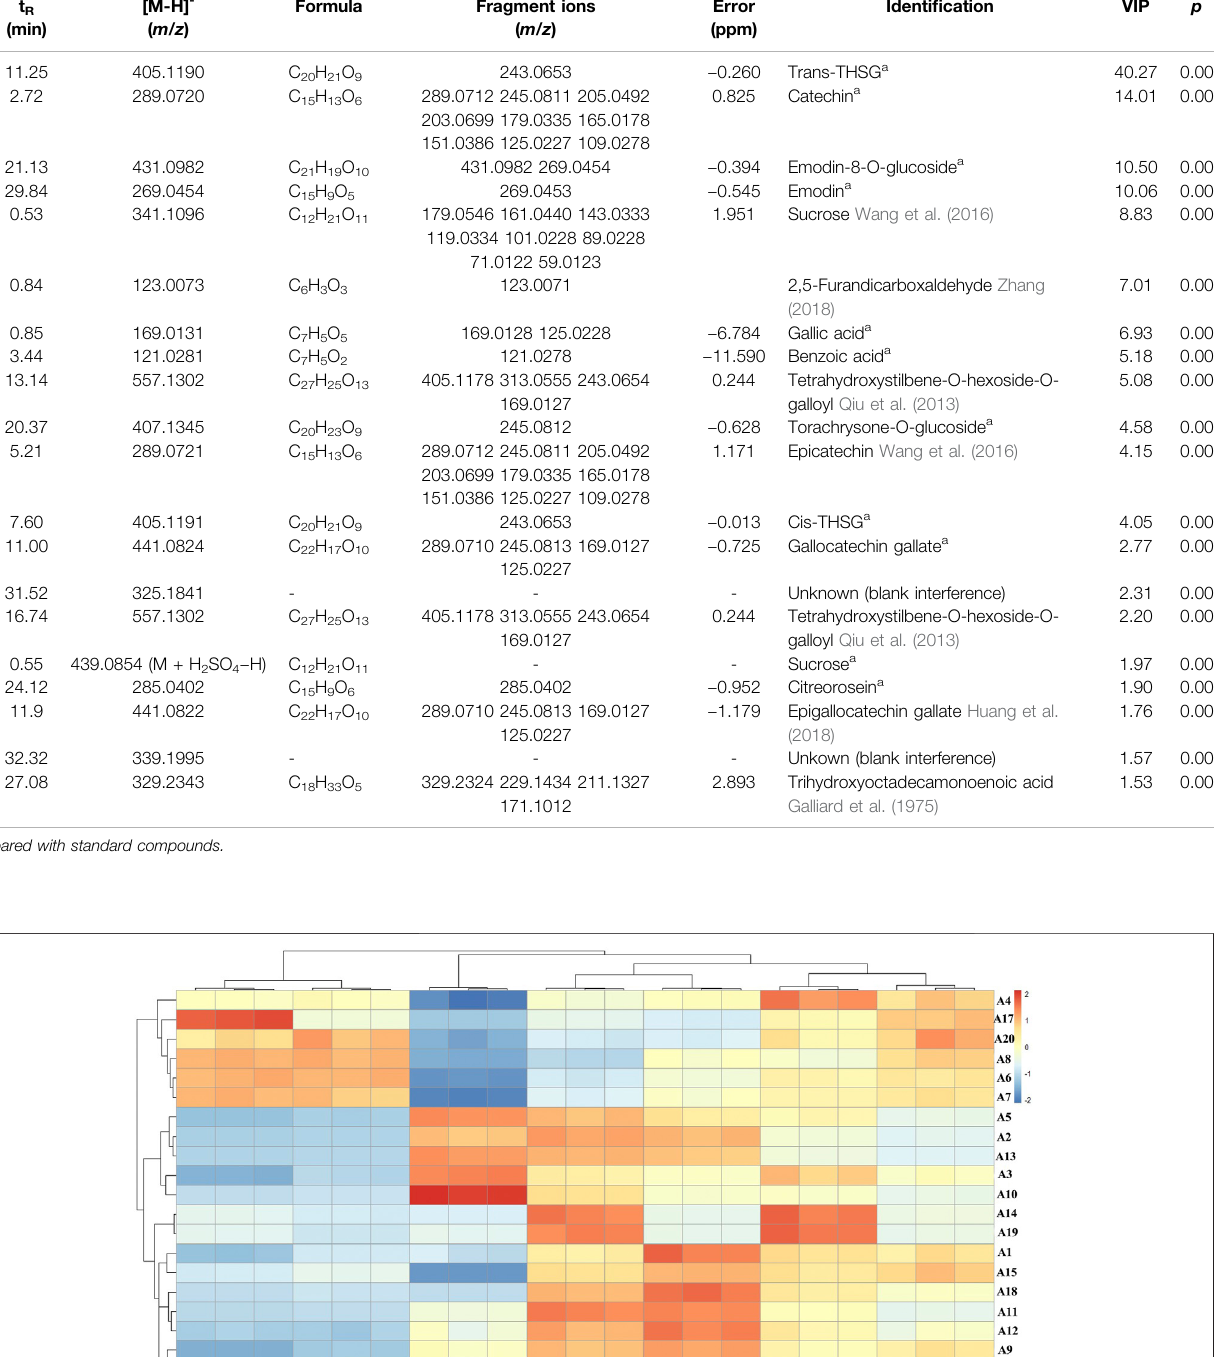
TABLE 1 | Details of potential chemical markers.